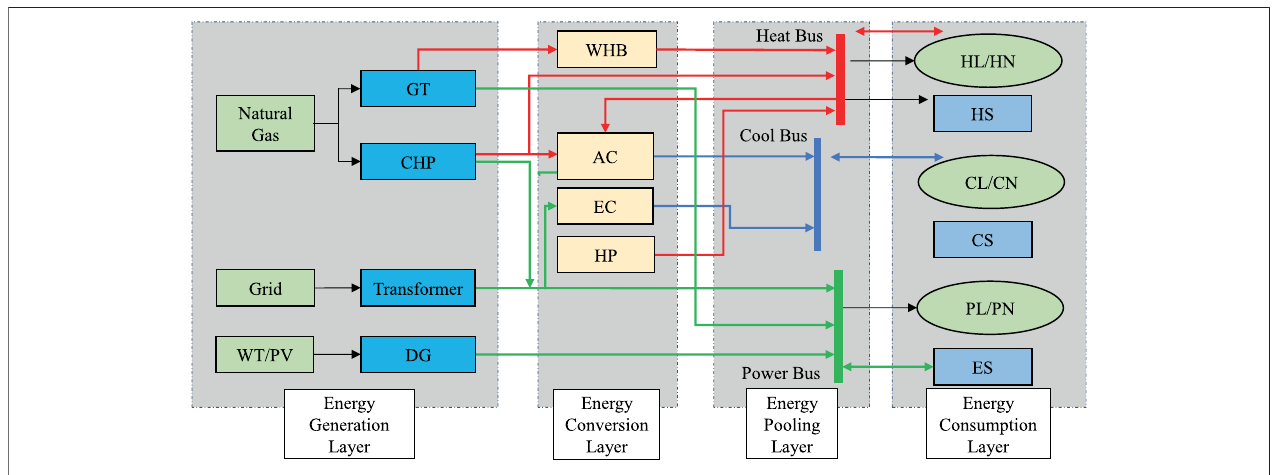
FIGURE 1 | Typical structure of the multi-energy fl ow coupling